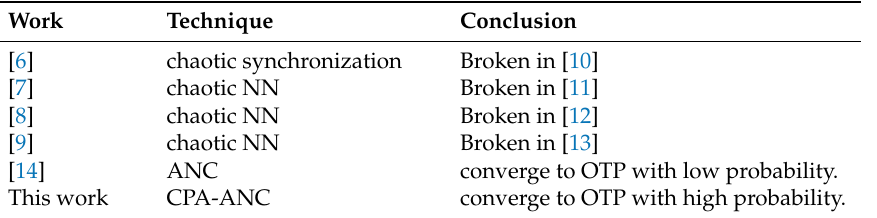
Table 4. Comparison with related